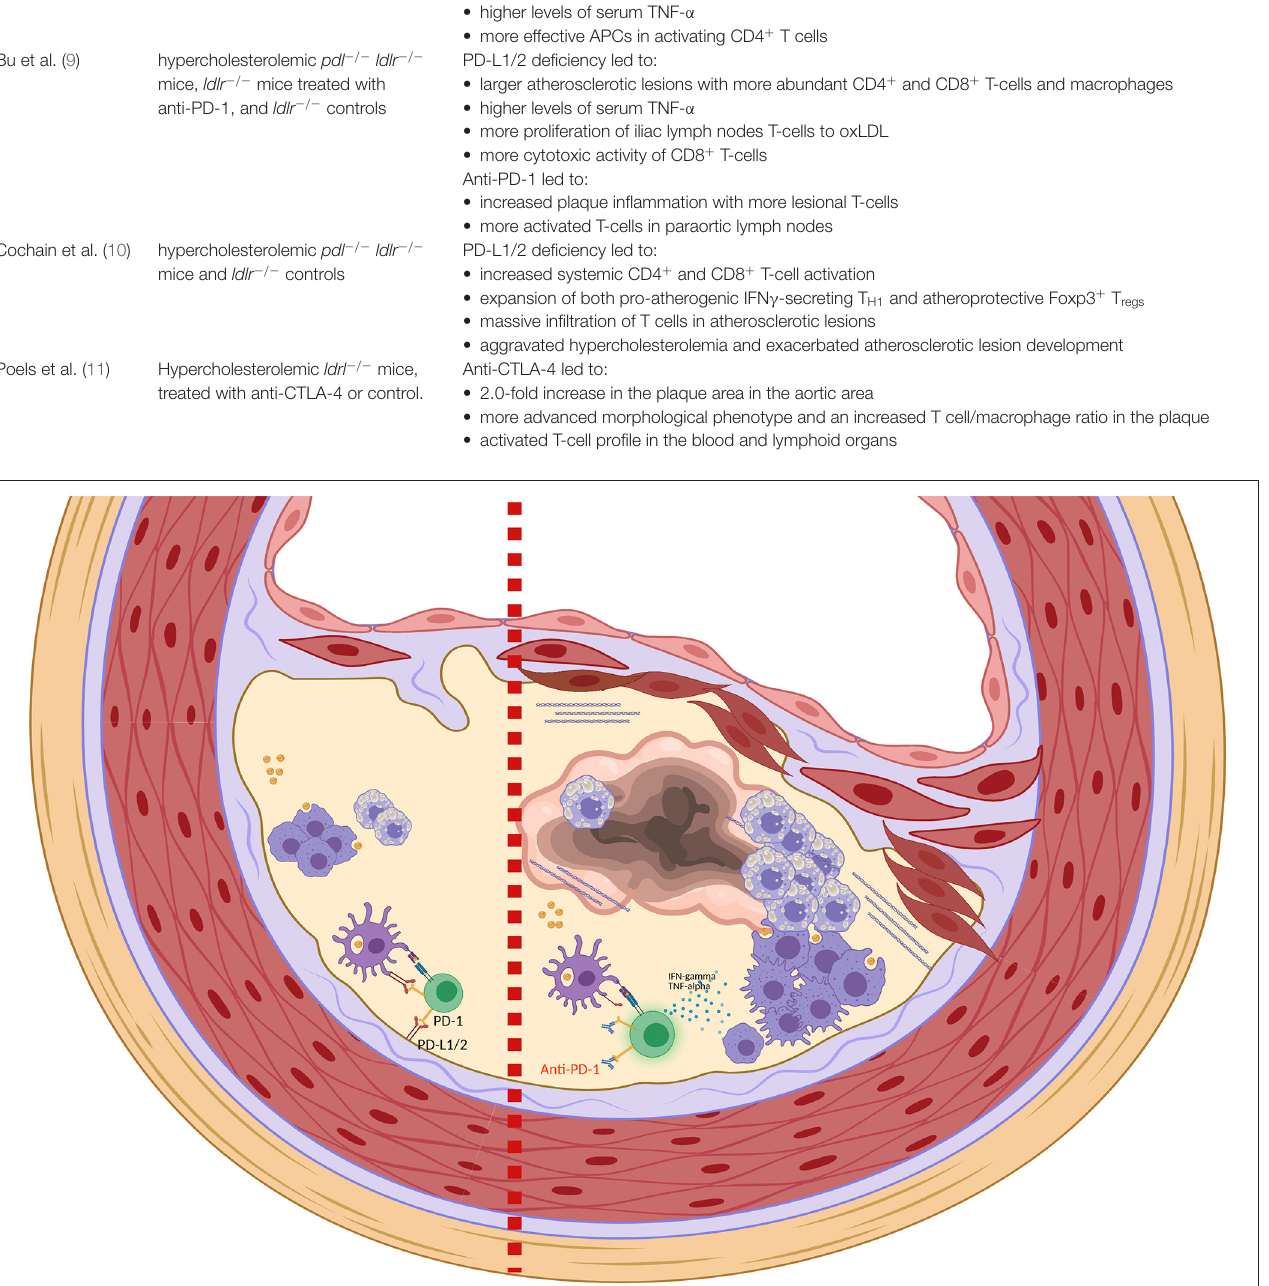
Frontiers in Cardiovascular Medicine |